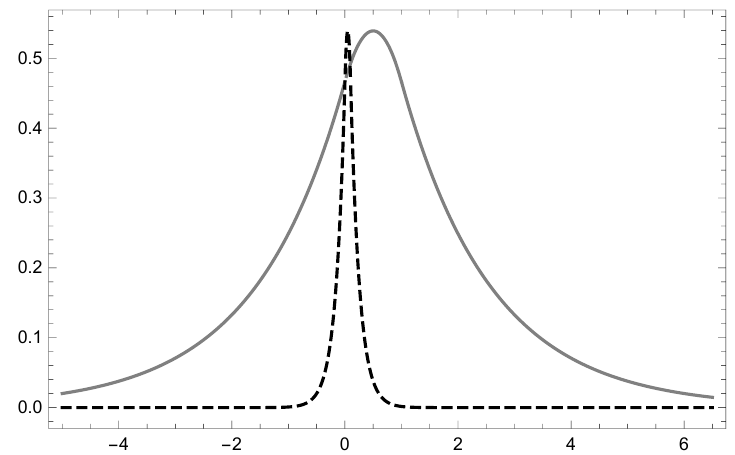
Figure 3 . Analysis of f ( x ) for small values of a=(cid:12) . For a (cid:12)xed small value of a=(cid:12) (in this case, a=(cid:12) = 1 = 10) the graph of the function f is a smooth symmetric bell centered at x = a= 2. As we increase the value of a , keeping a=(cid:12) (cid:12)xed, the bell spreads more in space. Dotted line corresponds to a = 0 : 1, full line to a = 1.